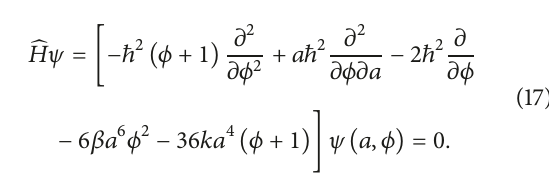
which substituted in (10) gives